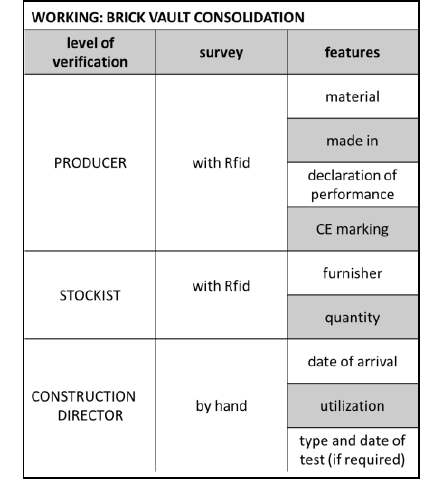
Figure 8: summary table features of the materials.